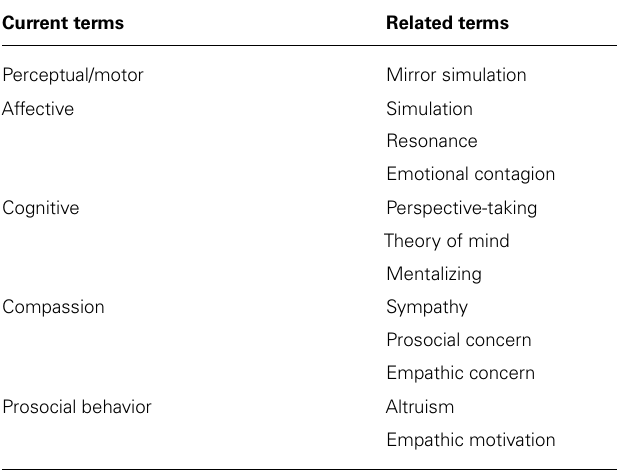
Table 1 |Associations between terms used here and related terms used in social cognitive neuroscience and social psychology (Preston and DeWaal, 2002; Keysers and Gazzola, 2007; DeWaal, 2008; Singer and Lamm, 2009; Preston and Hofelich, 2012; Zaki and Ochsner,